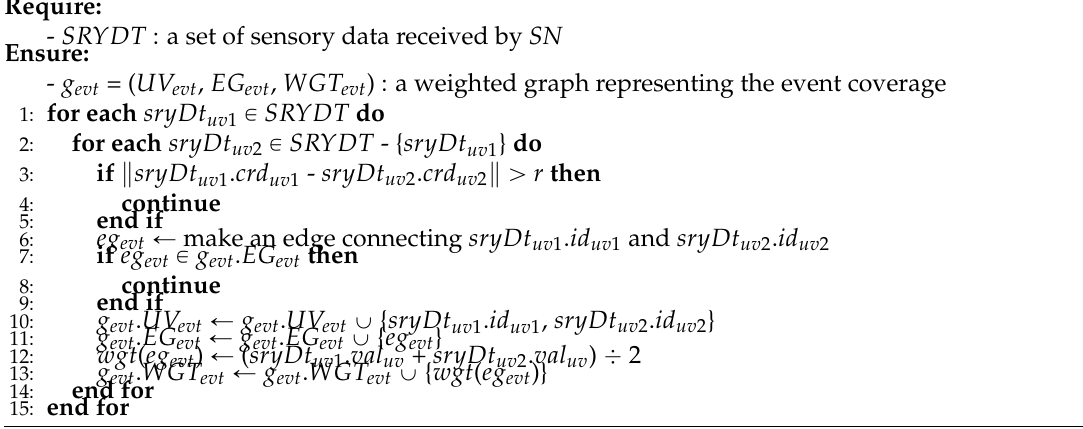
Algorithm 4 Event coverage